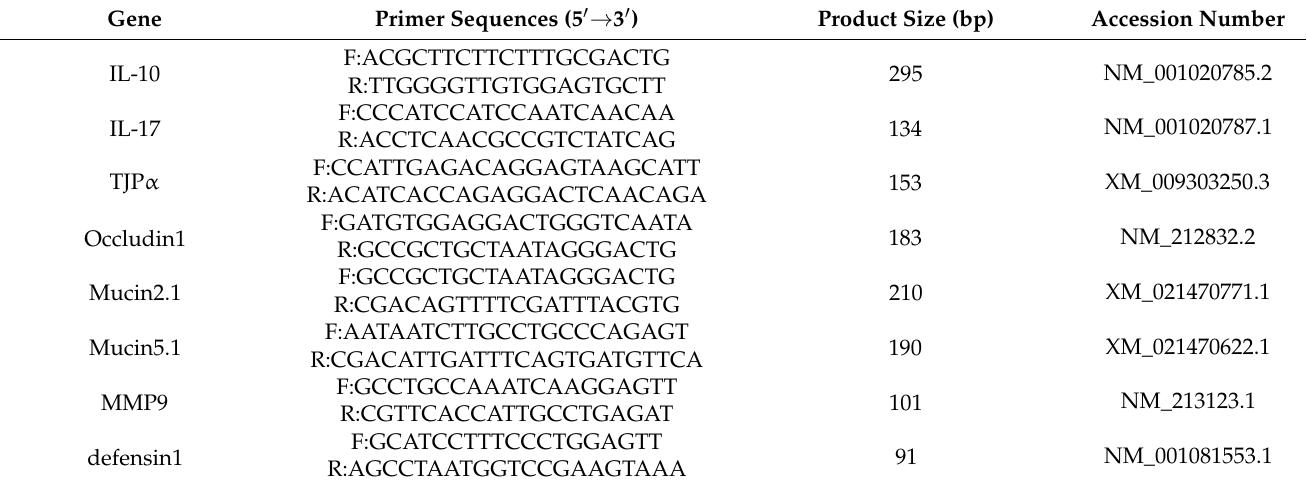
Table 1. The primers for gene expression used in this